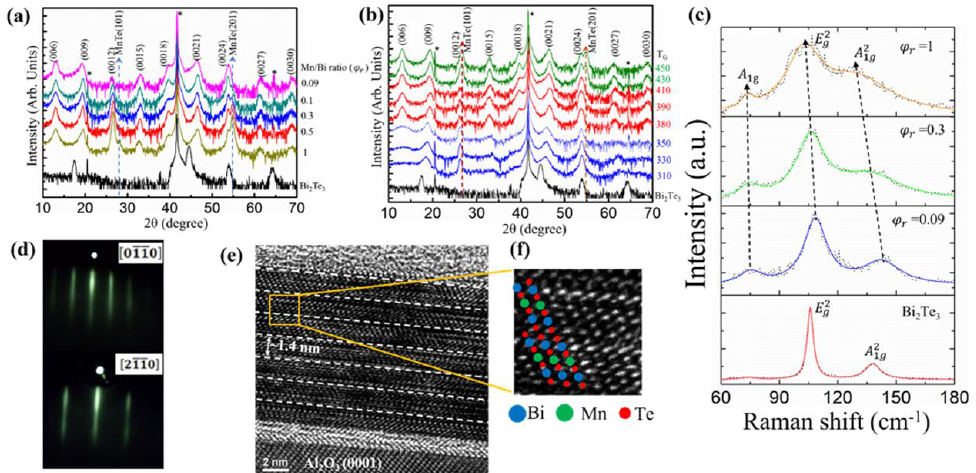
Figure 1. The structural characterizations of epitaxial MnBiTe films under varied growth conditions. The XRD diagrams for ( a ) T G fixed at 410 °C with varied φ 𝑟 and ( b ) φ 𝑟 fixed at 0.09 under varied T G (indicated on the right-hand axis). As indicated in the figure, the signals are marked as *: c -plane Al 2 O 3 substrate. The dashed vertical arrows highlight the emergence of the MnTe phase. ( c ) Raman spectra of films for varied φ 𝑟 . The dotted lines represent raw data; the solid color lines are fits through the raw data. ( d ) RHEED patterns of films along directions [ 01̅1̅0 ] and [ 21̅1̅0 ] , respectively. ( e ) TEM cross-sectional view of the film with φ 𝑟 = 0.09 and T G = 410 °C. ( f ) Enlarged TEM image and schematic structure of MnBi 2 Te 4 are superimposed: blue-Bi, green-Mn, red-Te.